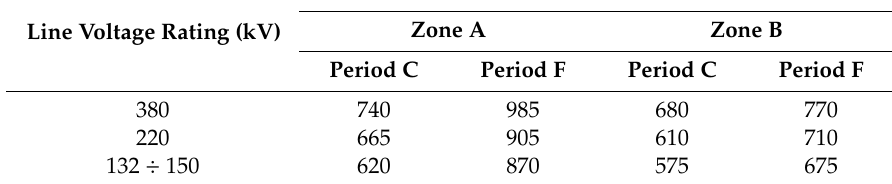
Table 11. Thermal limit current for the reference conductor as for standard CEI 11-60 (Adapted with permission from [31], CEI, 2005).